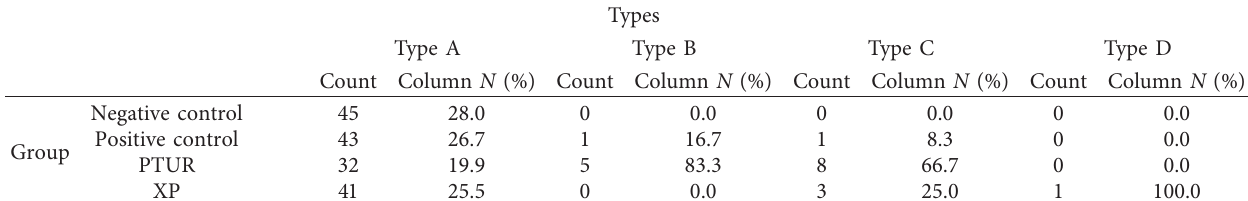
Figure 1: Digital microscope images of the specimen categories. (a) Type A, no defect. (b) Type B, fracture. (c) Type C, partial crack. (d) Type D, craze line. Table 2: Overall distribution of defects ∗